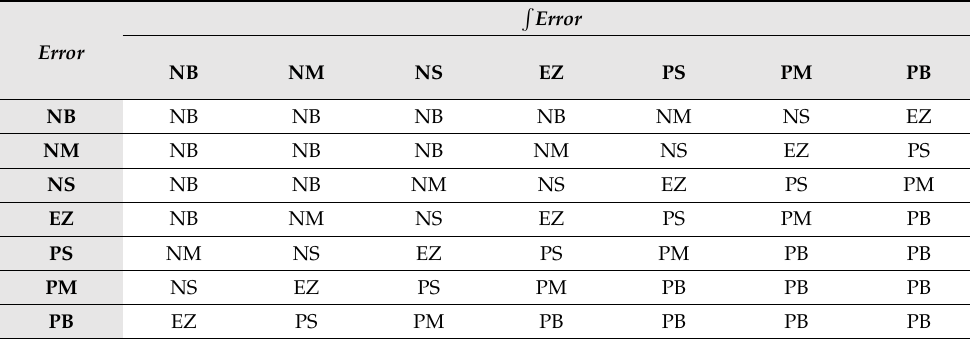
Table 1. Fuzzy logic control rule base tables.